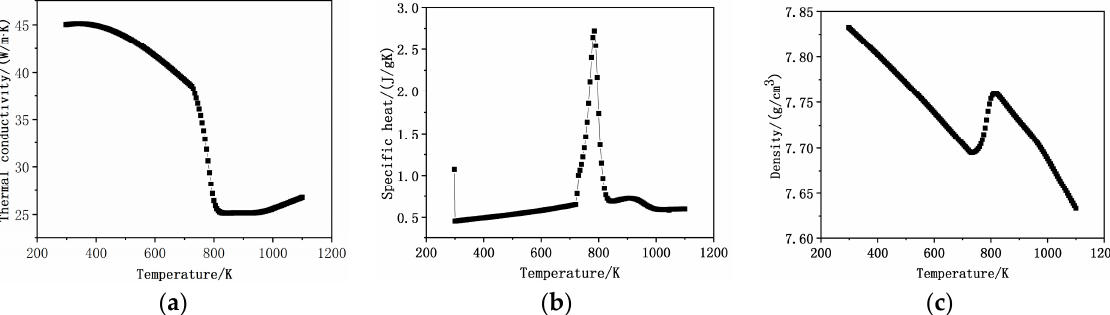
Figure 2. The thermo-physical parameters of 20CrMo steel; ( a ) Heat conduction; ( b ) Specific heat; ( c ) Density.